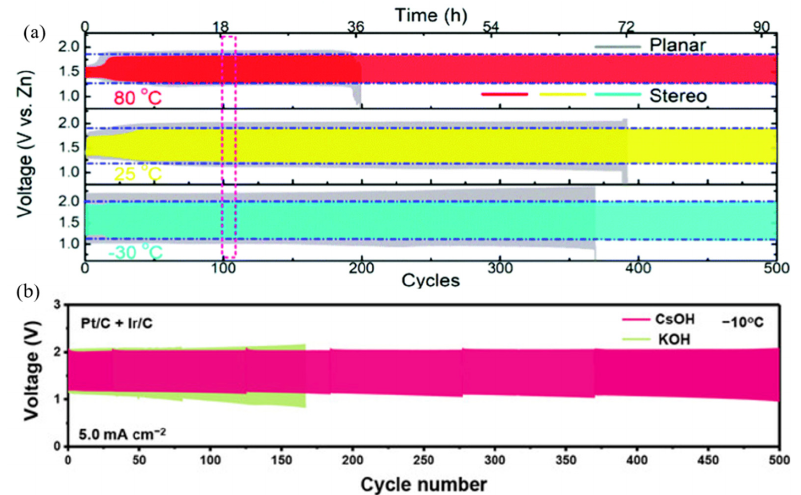
Figure 17. ( a ) Cyclization profile of stereo (red, yellow and green) and planar (grey) electrodes fab- ricated zinc–air batteries at varying temperatures, at 2 mA/cm 2 , Reprinted with permission from Ref. [94], Copyright 2021, The Royal Society of Chemistry. ( b ) Cyclization profile of zinc–air battery with CsOH-based electrolyte at − 10 °C, at 5 mA/cm 2 . Reprinted with permission from Ref. [97], Copyright 2021, John Wiley and Sons.